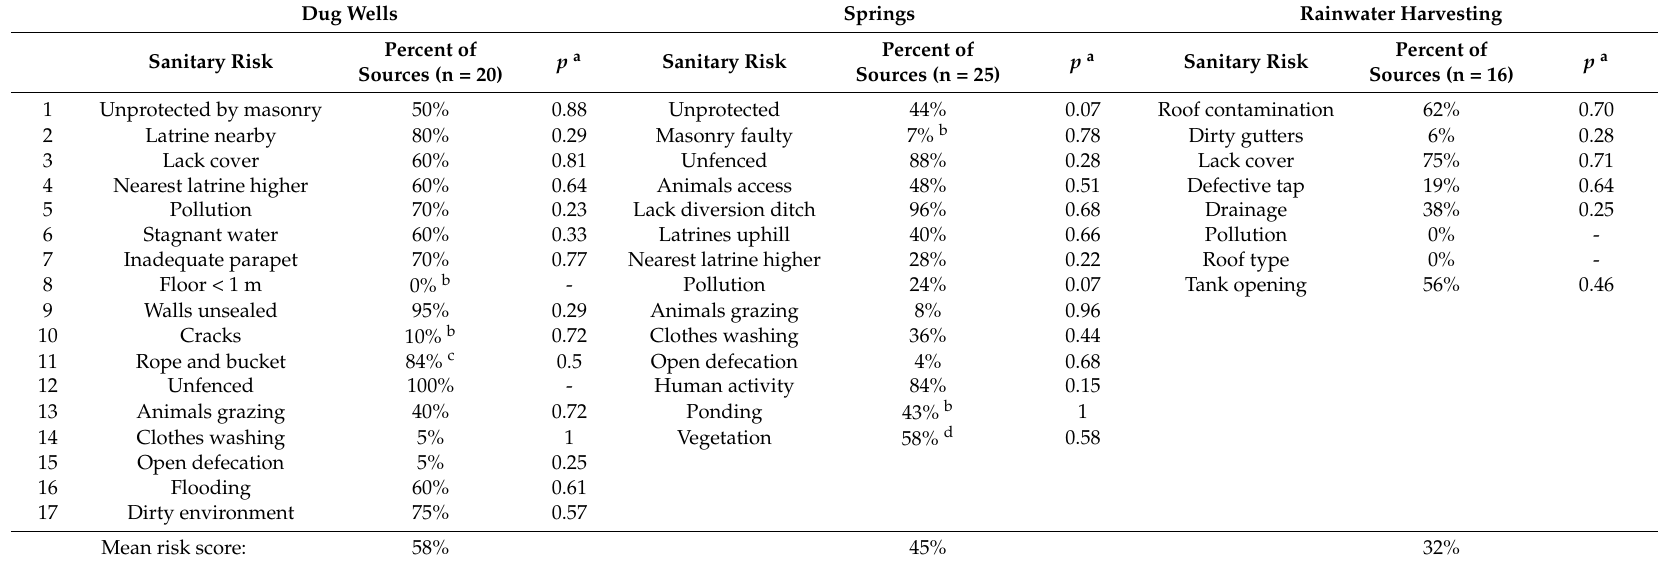
Table 3. Individual sanitary risk factors by water source